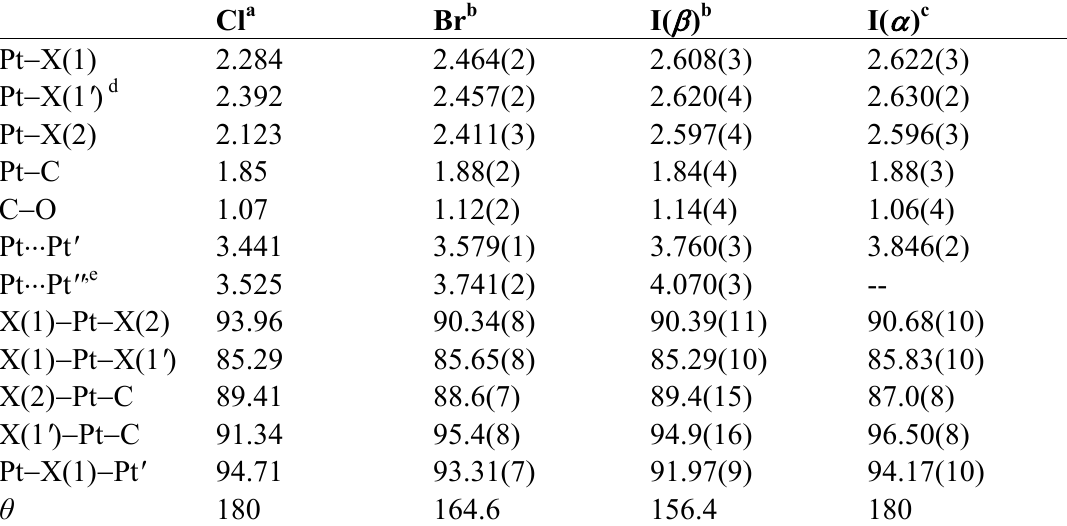
Table 1. Selected bond lengths (Å) and angles (°) in the molecular structure of trans -Pt ( μ -X) X (CO) 2 2 2